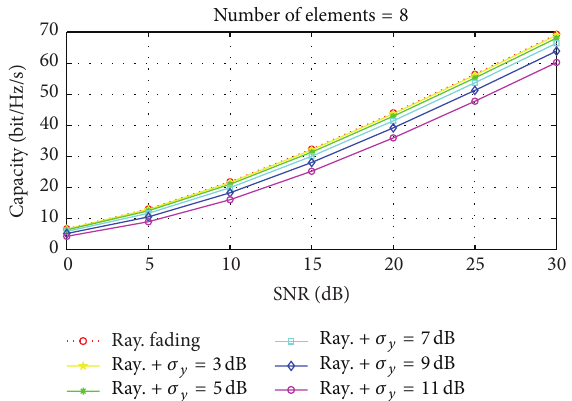
Figure 2: Capacity versus SNR for Rayleigh shadowing fading, with an 8 × 8 system.